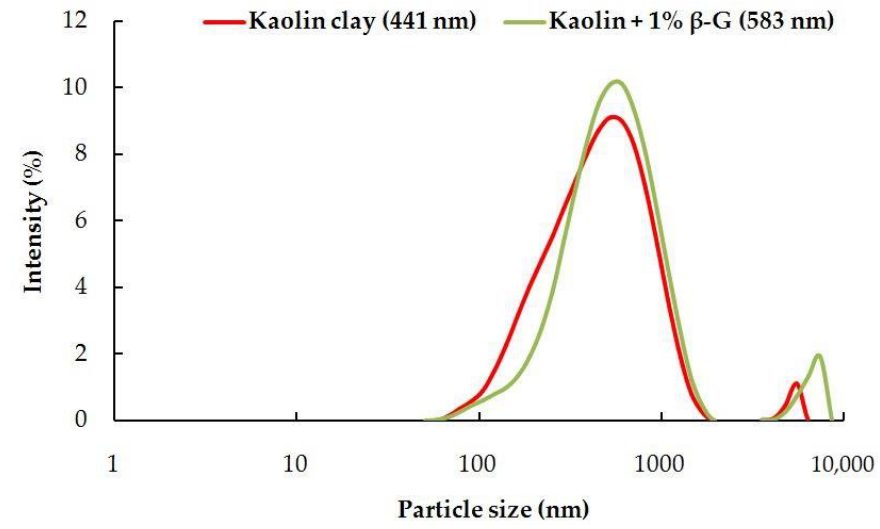
Figure 10. Particle size analysis of untreated and β -glucan-treated kaolin.